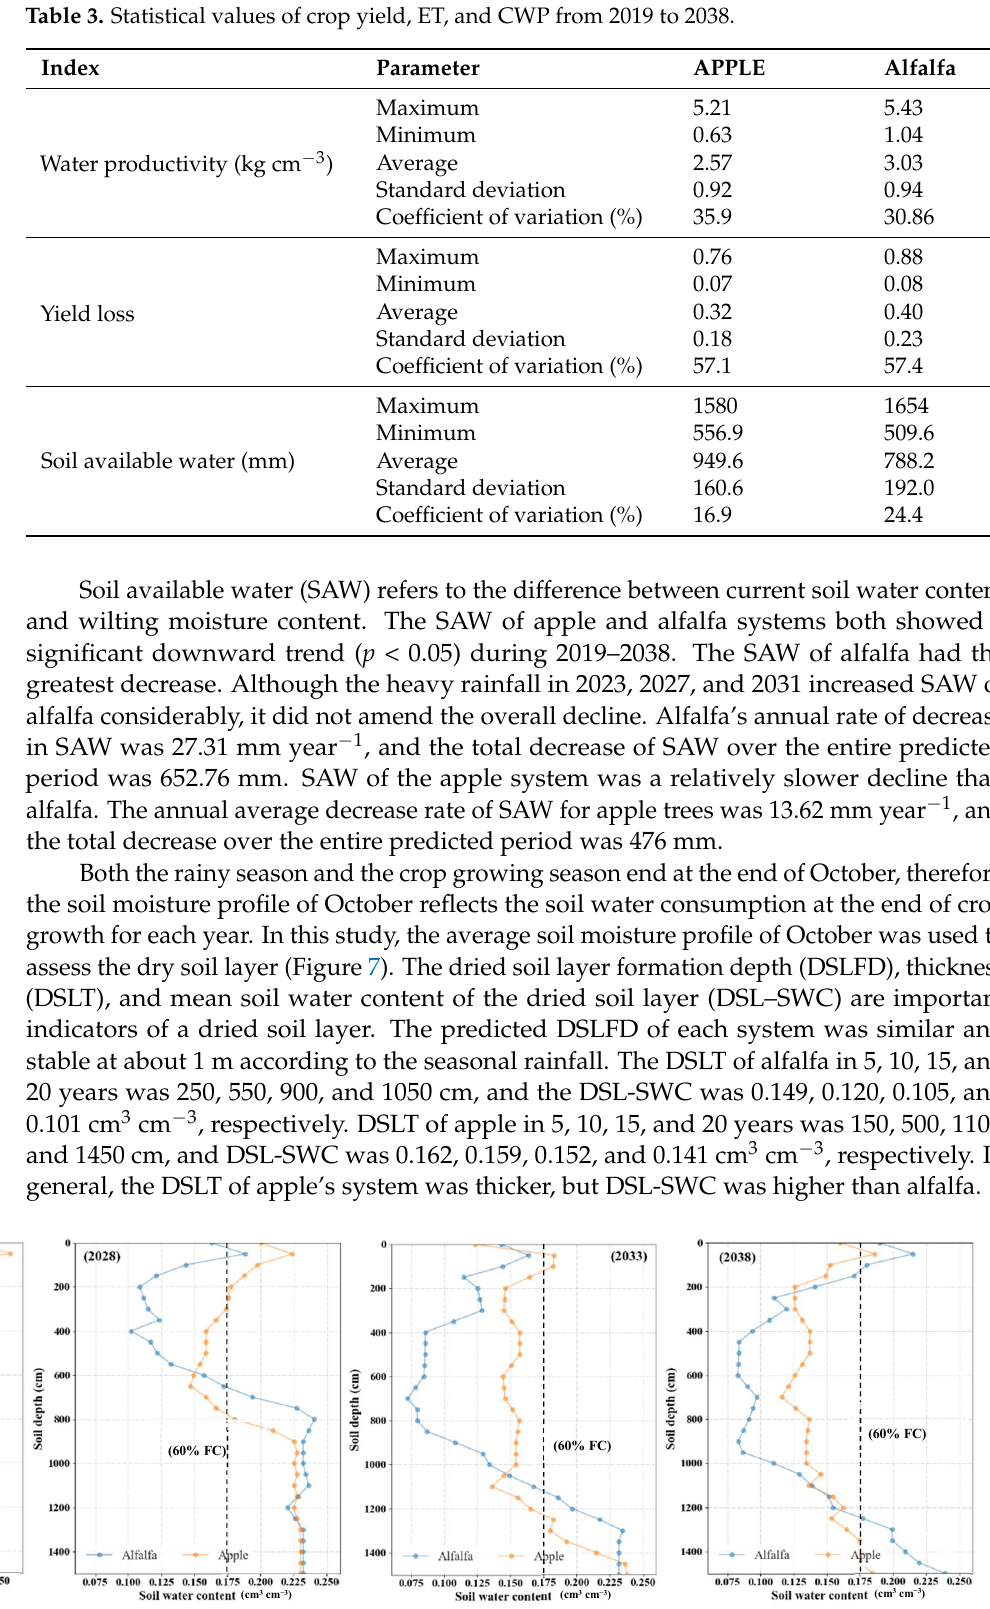
Figure 7. Soil water content (cm 3 cm −3 ) profiles of the 0–15 m soil layer in apple and alfalfa systems.